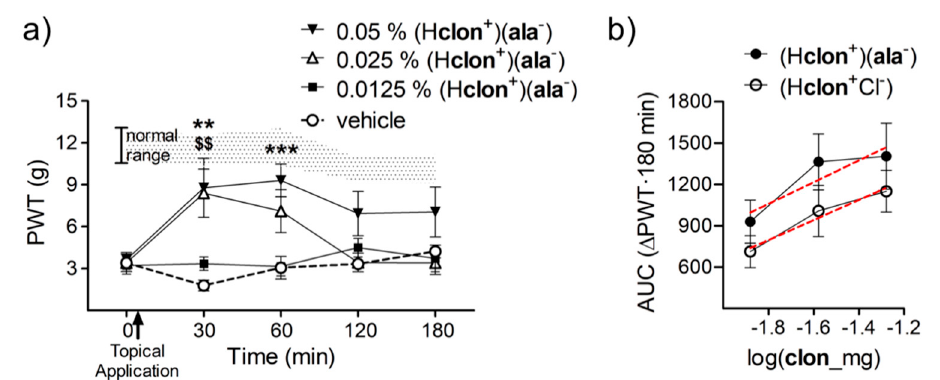
Figure 6. The effect of topical application of ethanol solvated (H clon + )( ala − ) and how it compares to its generically available counterpart (H clon + Cl − ). ( a ) The time course of change in PWTs after topical application of di ff erent doses of (H clon + )( ala − ). The shaded area represents PWT values